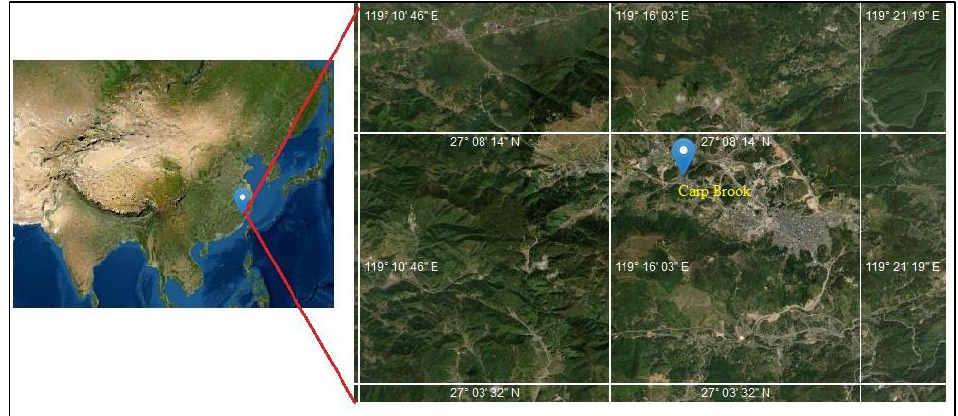
Figure 1. Location of the Carp Brook within Puyuan village, Zhouning county, in Southeast China’s Fujian province. The base map was from the ESRI world imagery.